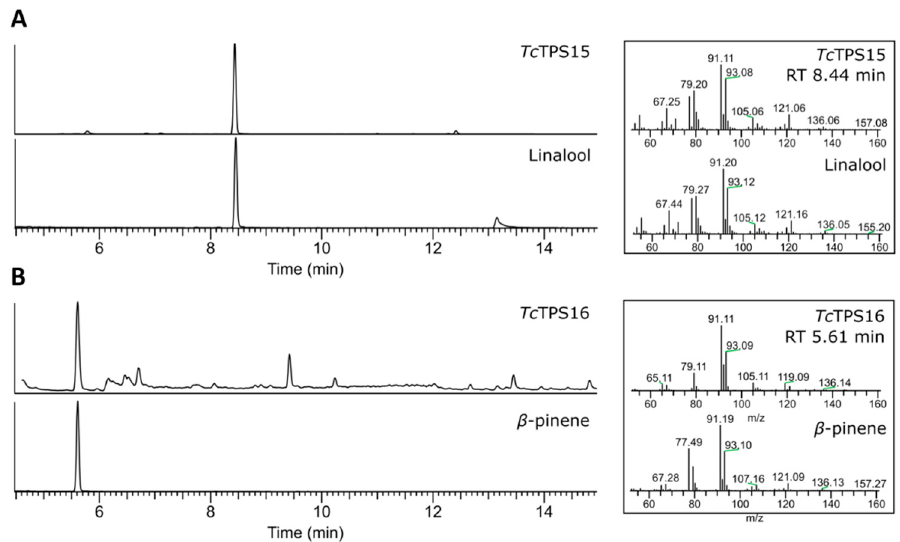
Figure 4. GC-MS analysis of the enzymatic products of Tc TPS15 and 16. ( A ) The metabolic profile of the Tc TPS15 product and linalool standard; ( B ) the metabolic profile of Tc TPS16 and β -pinene standard.